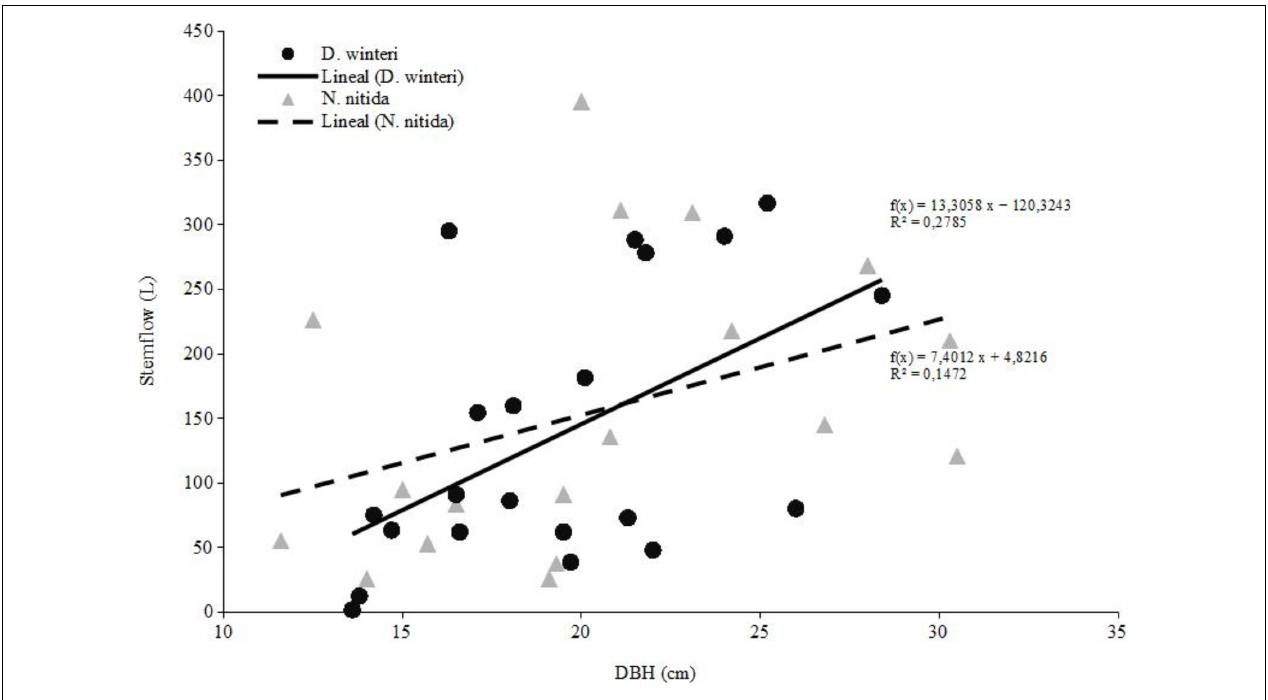
FIGURE 3 | Total spring-summer stemflow of dominant